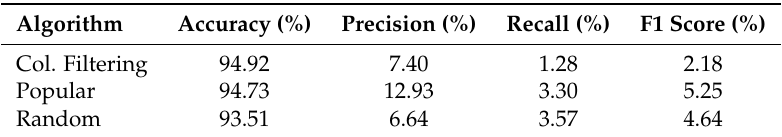
Table 4. Performance metrics for game apps by recommender algorithm. Train: 15 October 2018 to